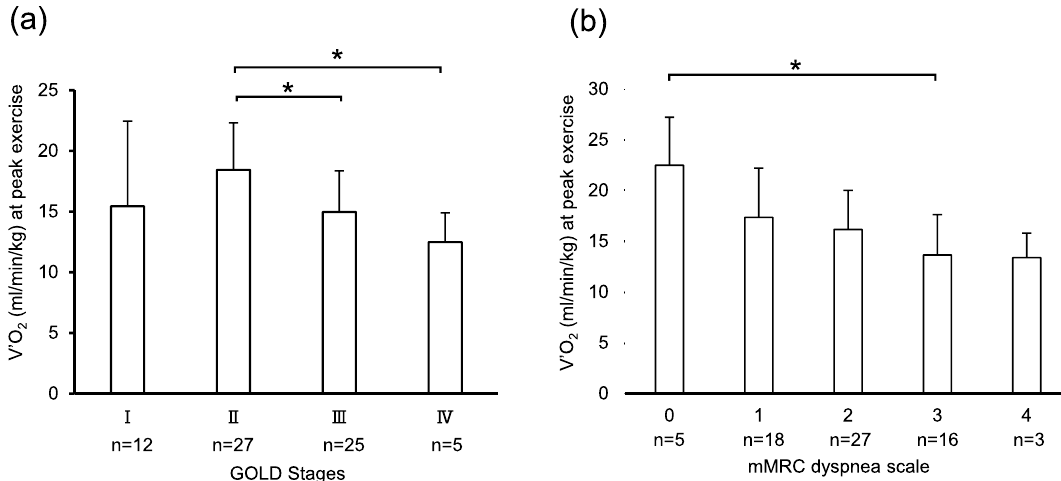
˙ VO 2 oxygen uptake,